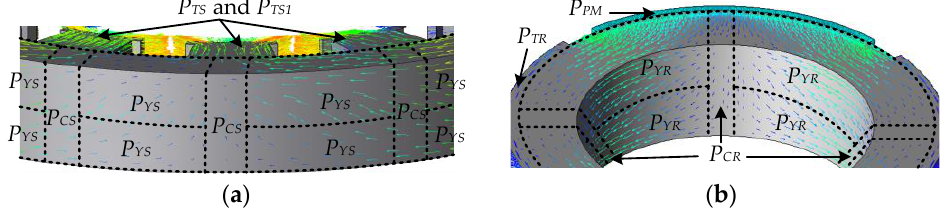
Figure 4. Relationship between air-gap permeance and rotor position.